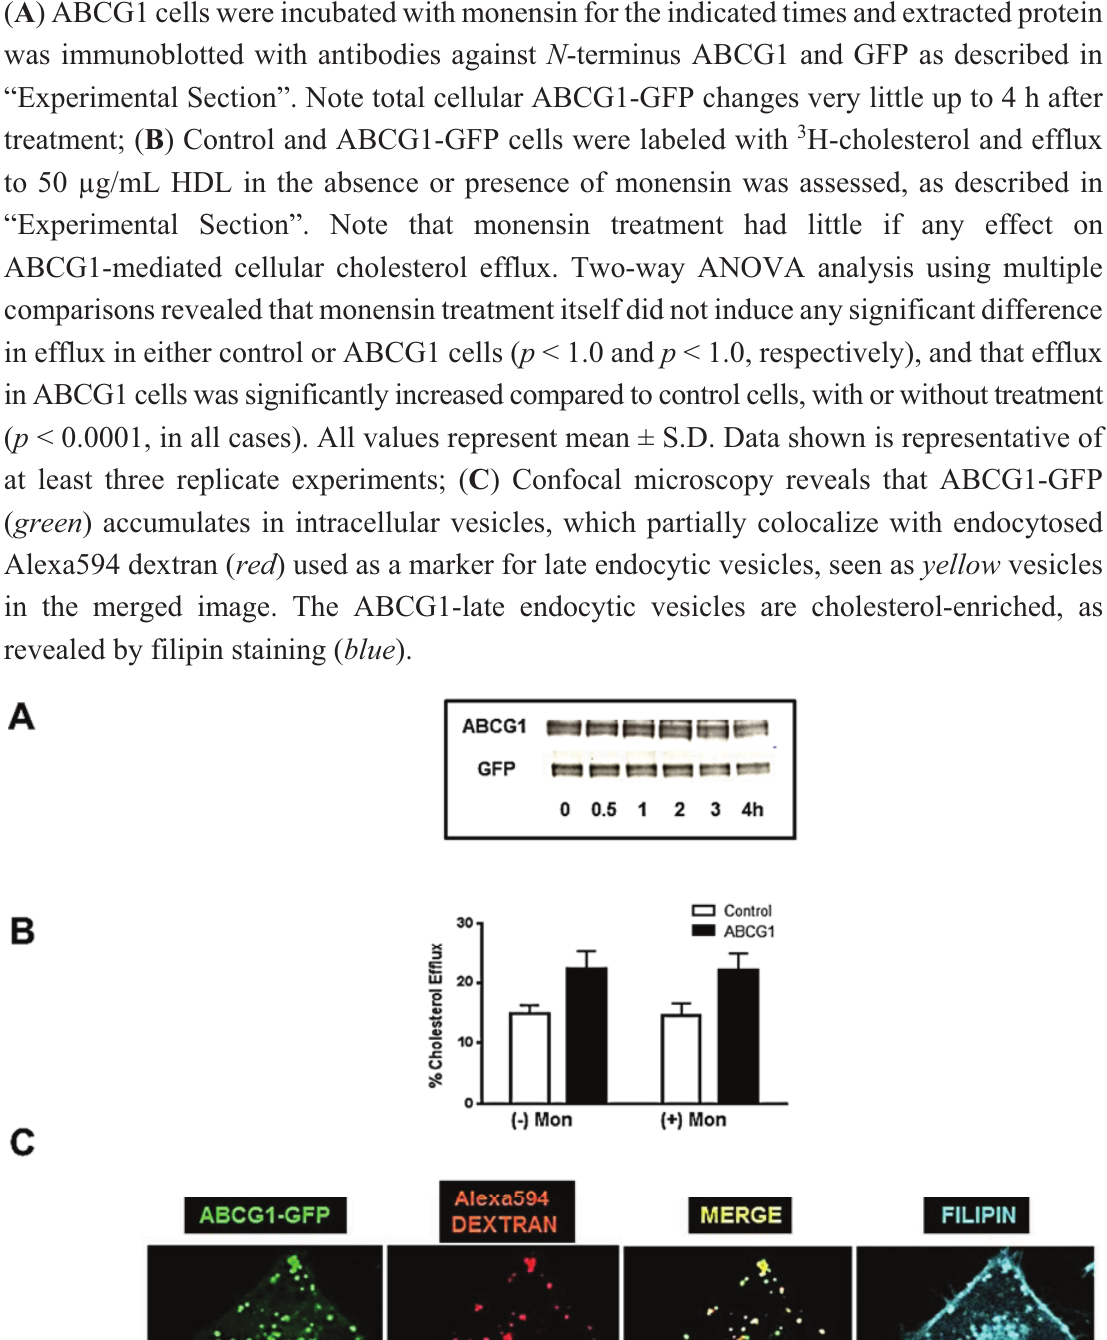
Figure 8. Endosomal ABCG1-GFP enhances cellular cholesterol efflux . PM-derived ABCG1 trapped in late endosomes/lysosomes by monensin enhances efflux to